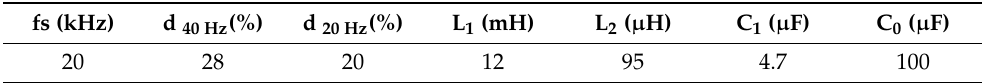
Table 2. Project of a 1 kW 3 φ SEPIC-type rectifier.